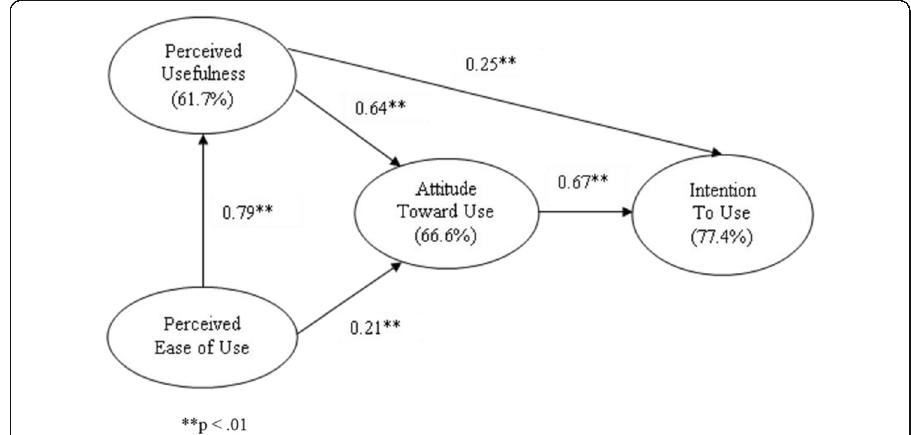
Fig. 3 Standardised path coefficients of the research